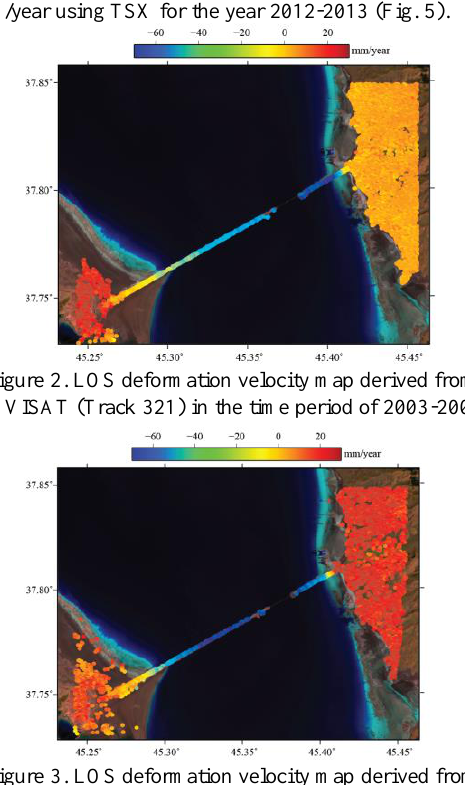
Figure 5. LOS deformation velocity map derived from TSX in the time period of 2012-2013.